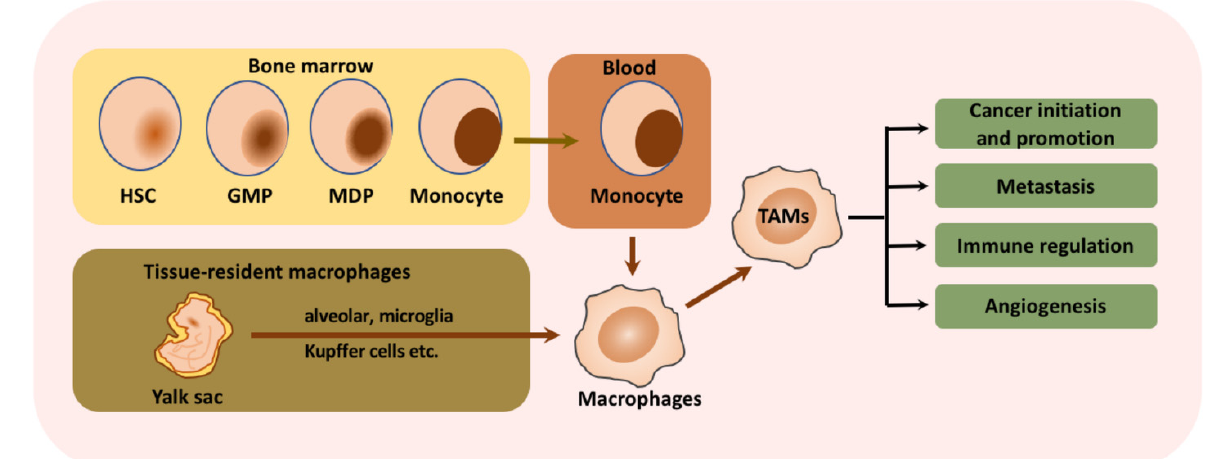
Figure 1. Schematic illustration of the origin of tumor-associated macrophages and their functions. Macrophages are derived from hematopoietic stem cells (HSCs), which are differentiated into granulocyte-macrophage progenitors and further into monocyte-dendritic cell progenitors. Other than HSCs, tissue-resident macrophages are key sources of macrophages that differentiate in situ into alveolar macrophages, Kupffer cells, and brain macrophages. These monocytes released into the bloodstream are activated in the tumor microenvironment and undergo drastic changes that facilitate tumor proliferation, metastasis, angiogenesis and immune modulation. Reproduced from Lin et al. [47] which is licensed under a Creative Commons Attribution-(CC BY 4.0) International License